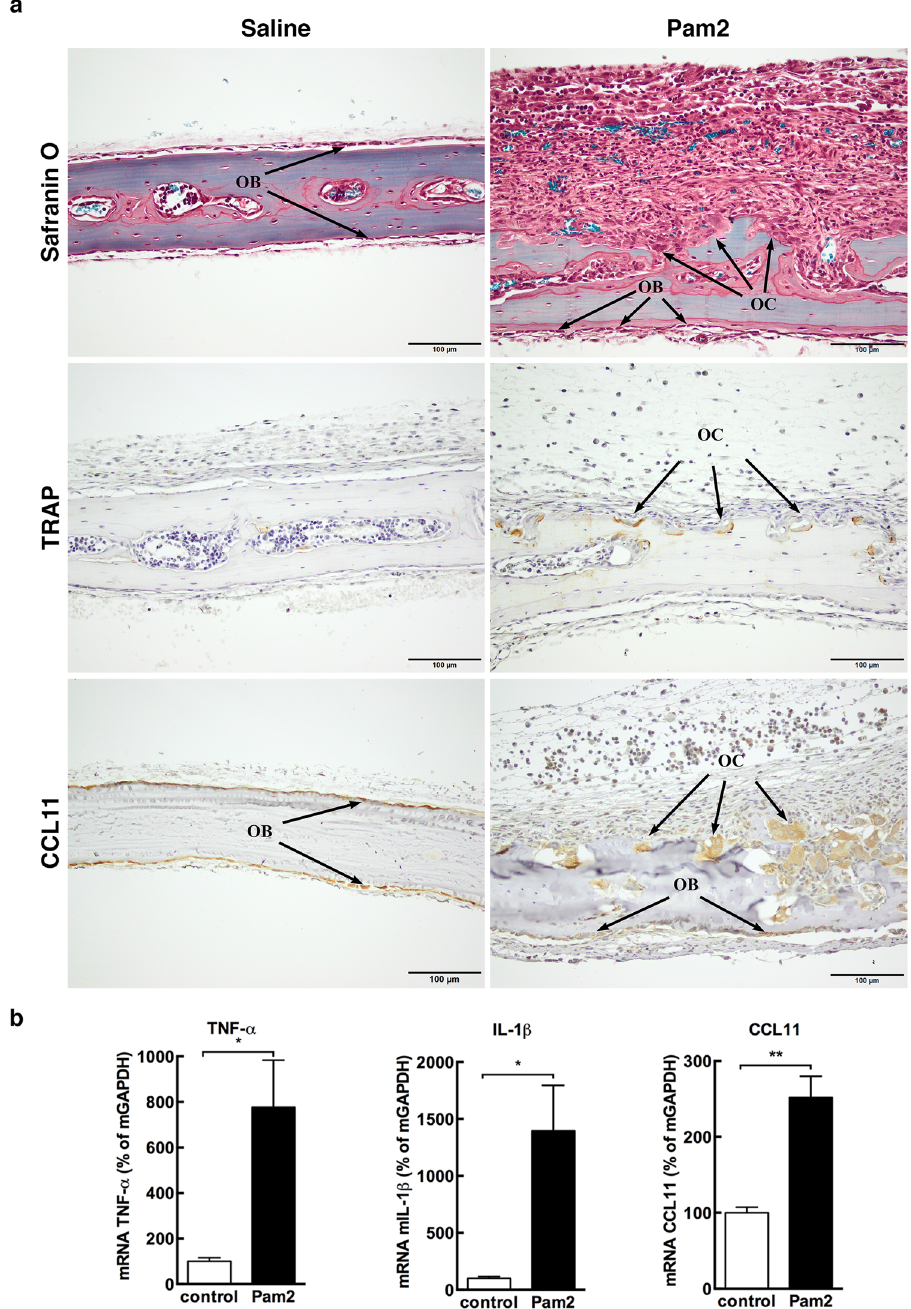
Figure 1. Injection of Pam2 stimulates osteoclast formation, bone resorption and increased CCL11 expression in mouse parietal bones. ( a ) Sections of paraffin embedded parietal bones from mice given subcutaneous injections of saline (left panel) and 50 μ g Pam2 (right panel) stained with Safranin O and immunohistochemically for TRAP and CCL11 respectively. Arrows point few osteoblasts (OB) and osteoclasts (OC). ( b ) mRNA expression of TNF- α , IL-1 β and CCL11 in homogenized parietal bones from mice subcutaneously injected with Pam2 (n = 4) compared to saline control (n = 5). Data expressed as means ±